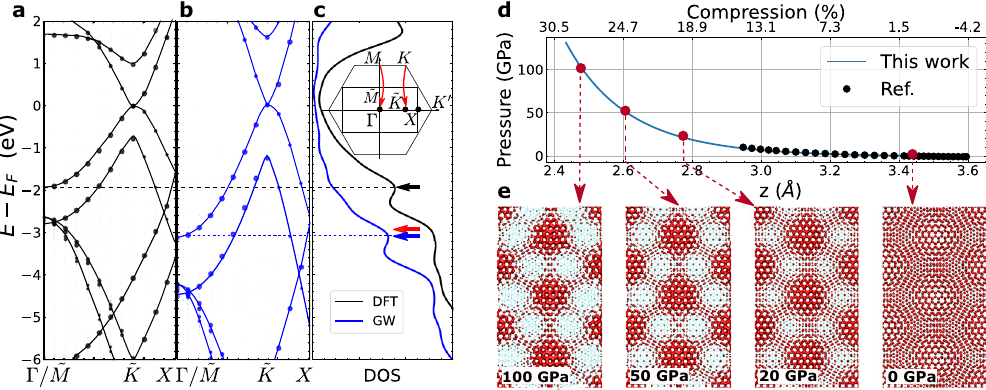
Fig. 1 Electronic structure of ideal bilayer graphene and pressure-induced density localization in tBLG. Bandstructure of ideal bilayer graphene computed with a DFT and b GW. Due to the rectangular cell, corresponding bands are refolded onto Γ -point. Lines in band structure are guides for the eyes. c Comparison of DFT and GW DOS. Red arrow indicates where should be an experimental peak corresponding to the fl attening of the band in ARPES in refs. 80,81 . The onset fi gure schematically shows a comparison of the rectangular and hexagonal fi rst Brillouin zones. d Pressure--interlayer distance (compression) curve for ideal bilayer graphene. Ref. 76 . e Charge density of the Dirac point KS states at corresponding pressures of 6° tBLG. The isovalue is the same for all density